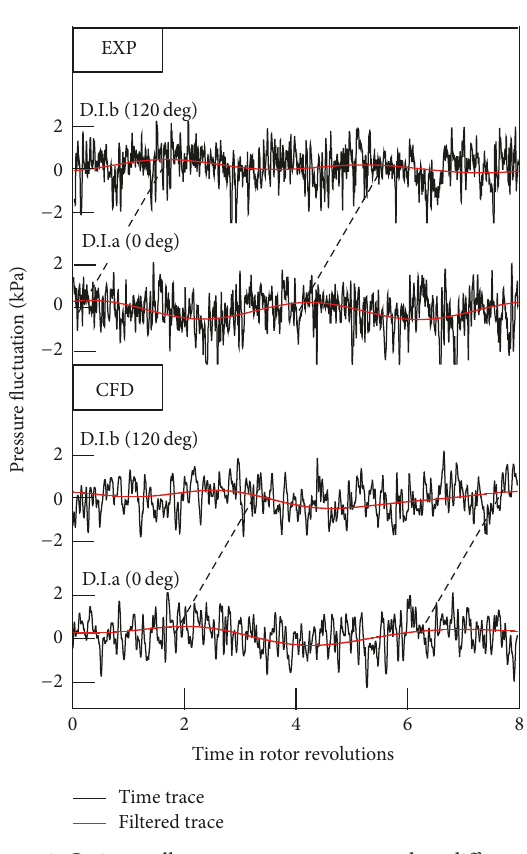
Figure 6: Casing wall pressure traces measured at diffuser inlet circumferential direction (D.I.a and